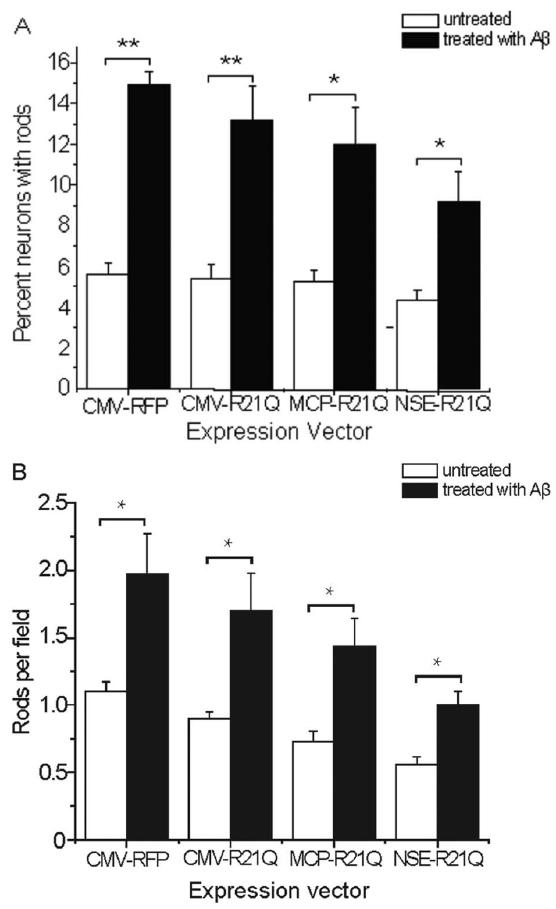
Figure 5. CofilinR21Q-mRFP reports on rod formation in hippocampal neurons in response to A b d/t treatment. (A) The fraction of cofilinR21Q-mRFP expressing neurons that formed rods after treatment with A b d/t is 2 to 3 fold higher than for untreated neurons, regardless of which promoter drives expression, although more rods are detected when cofilin-R21Q-mRFP expression is greatest. (B) The number of rods per field in A b d/t treated neurons expressing cofilinR21Q-mRFP is about 2 fold higher than the corresponding non- A b d/t treated controls regardless of which promoter drives expression. (*Significant at p , 0.05, **Significant at p , 0.005, compared to their appropriate non-A b d/t-treated control group). doi:10.1371/journal.pone.0083609.g005 relative abundance of rods in a region of the coverslip for cells with uniform plating density, or as a number of rods per neuron (number rod index), the number of rods per field from at least 20 random fields (normalized to cell number if neuronal distribution was uneven) was recorded. Unless otherwise stated, all experi- ments were repeated a minimum of three times using indepen- dently prepared cell cultures. Levels of significance compared to the control (single condition variable) were calculated using the student ‘‘T-test’’ and are reported as significant if p , 0.05.